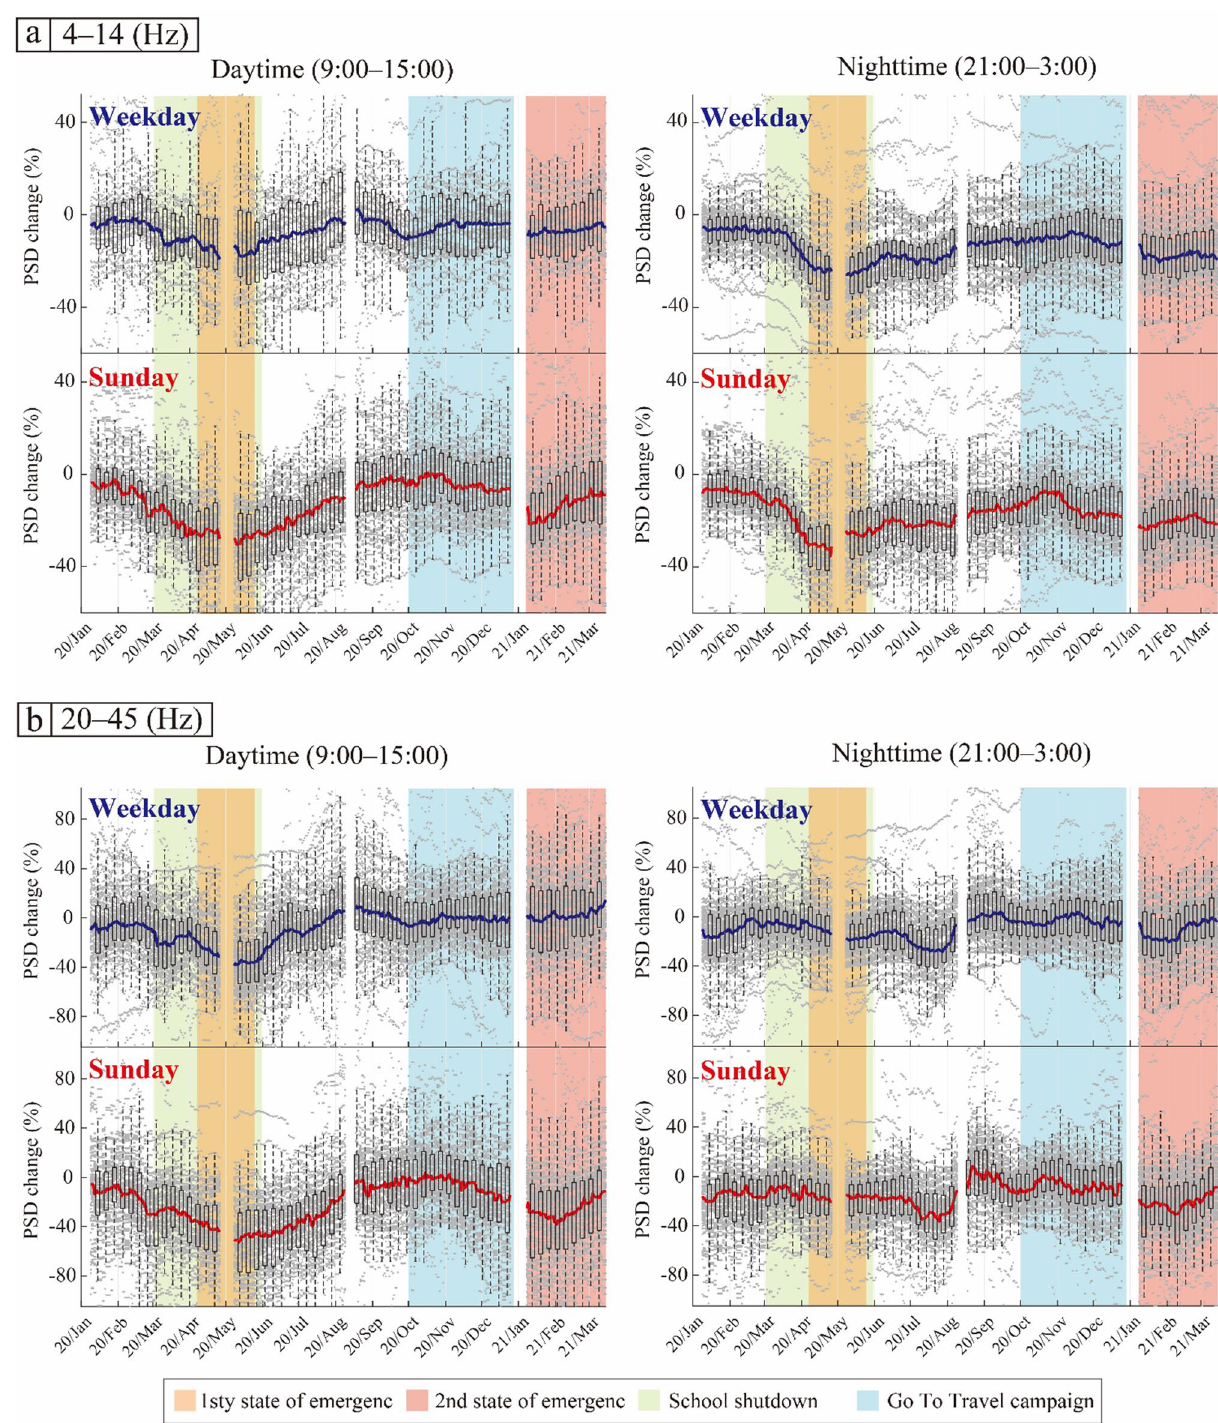
Figure 7. Corrected temporal changes in the relative noise level in the frequency range ( a ) 4–14 Hz and ( b ) 20–45 Hz. Left and right panels show the result of daytime and nighttime, respectively. The gray dots represent the corrected temporal changes at each station that show correlation coefficients > 0.2 (circles in Fig. 2b,c). The blue and red solid lines indicate the median values on weekdays and Sunday, respectively. The boxes represent the first and third quartiles and the error bars represent the minimum and maximum values within the ×1.5 the interquartile range from the first and third quartiles. The boxes and error bars were plotted for every 7 days. The orange and pink shaded areas represent the periods of the first and second states of emergency in Tokyo, respectively; the green shaded area represents the period of school closures; and the light blue shaded area represents the period of the Go To Travel